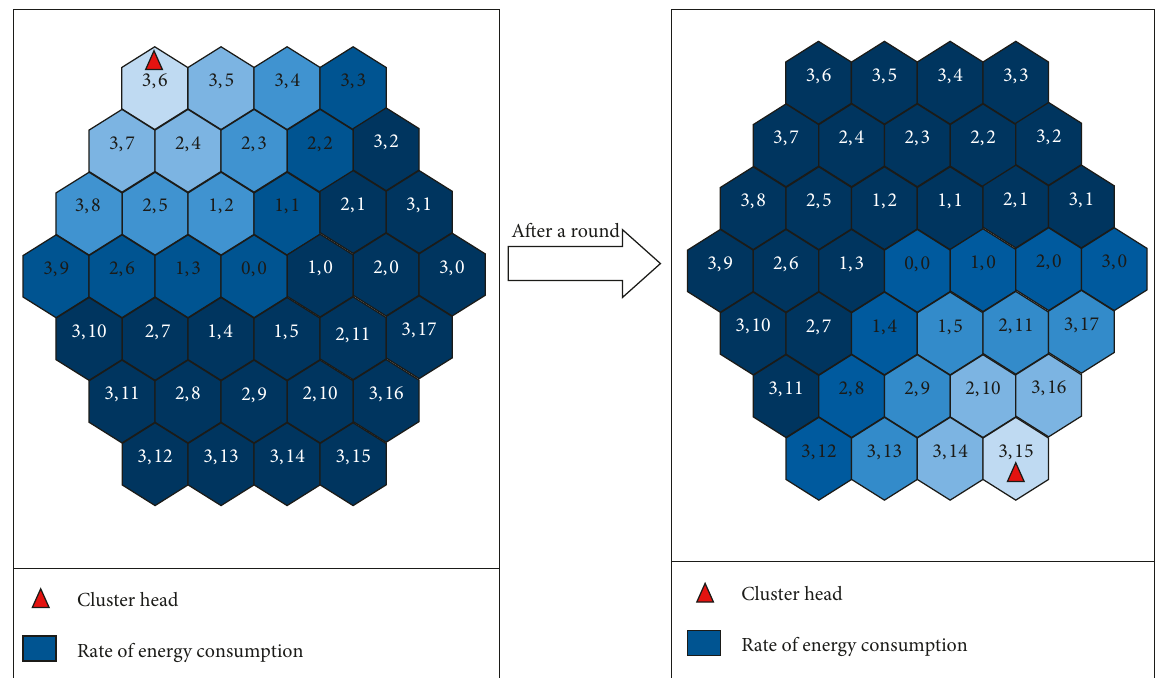
Figure 5: Energy balancing in the intracluster within a